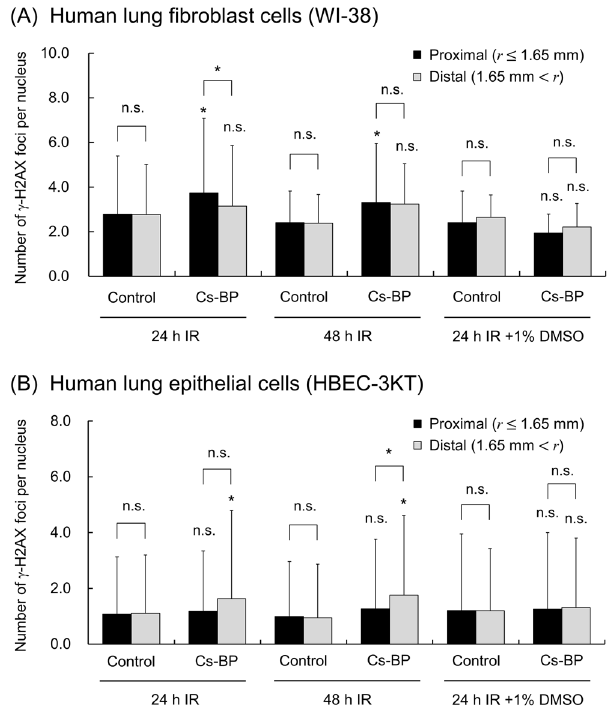
Figure 3. Cumulative γ− H2AX foci detected after Cs-bearing particle (Cs-BP) exposure. ( A ) Normal human lung fibroblast cells (WI-38). ( B ) Normal human lung epithelial cells (HBEC-3KT). The error bars indicate the standard deviations. The exposure time was set as 24 h or 48 h, and the irradiation is noted as IR in this Fig. 3. To check the impact of intercellular communication, 1% DMSO was added 2 h prior to the beginning of the 24 h exposure. The symbol of * and n.s. represents 5% significant difference and no significant difference, respectively, vs the corresponding control (non-irradiated)